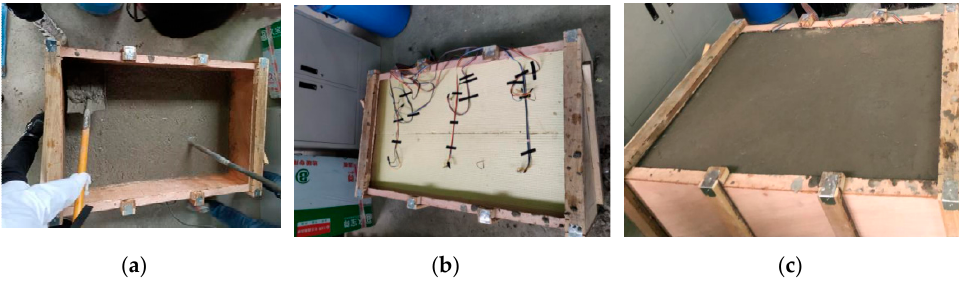
Figure 7. Wallboard making process. ( a ) Concrete pouring and vibration; ( b ) insert connector and insulation; ( c ) production completed.